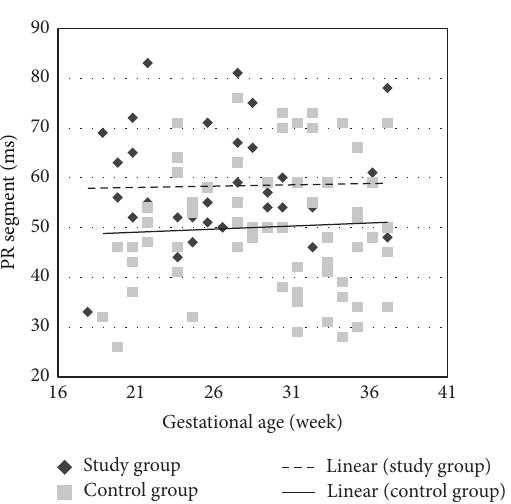
Figure 1: PR segments of study group and control group. Lines indi- cate 50th %ile